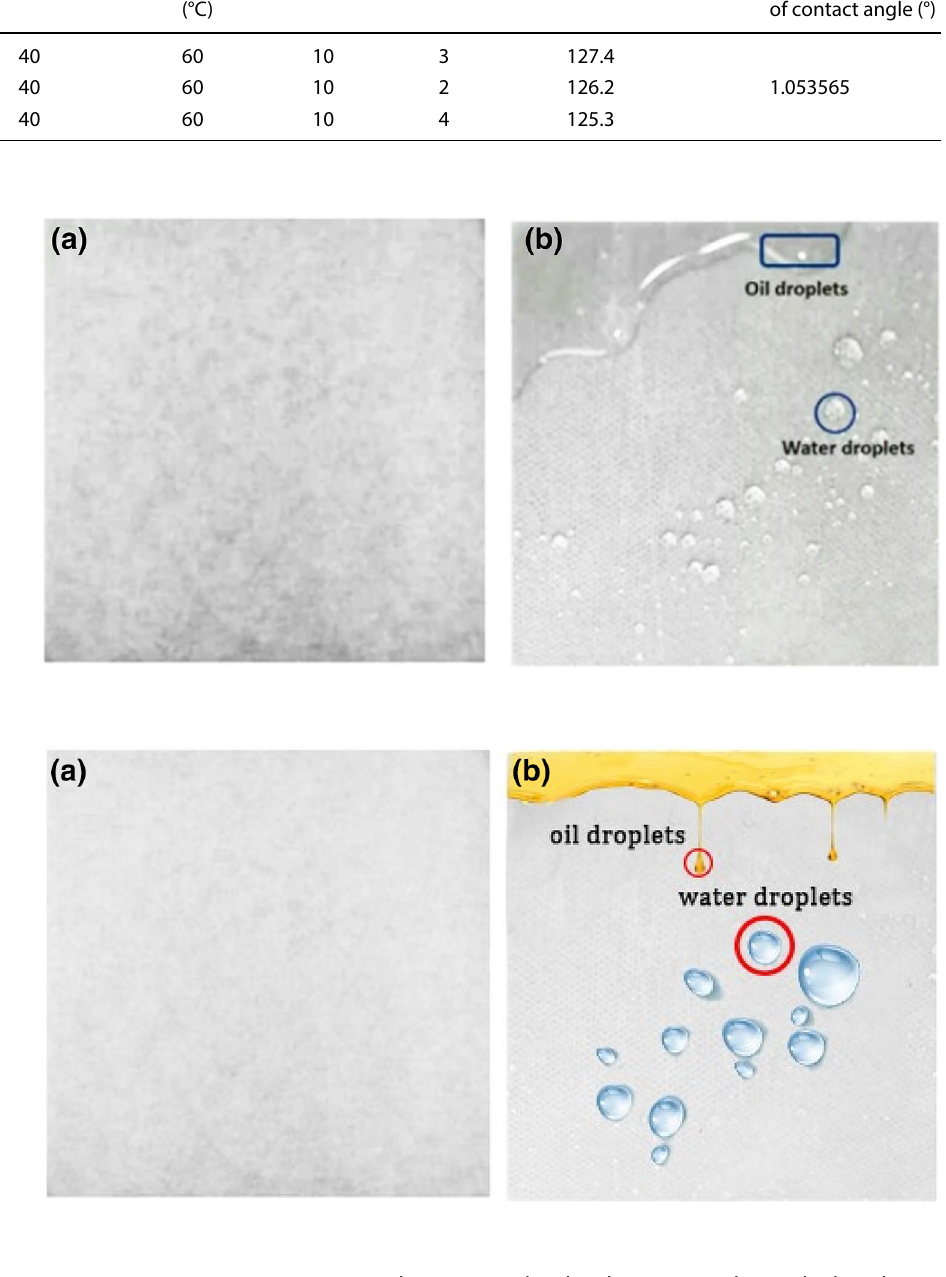
Table 7 Optimized preparation of hydrophobic nonwoven cotton fabric Sample no